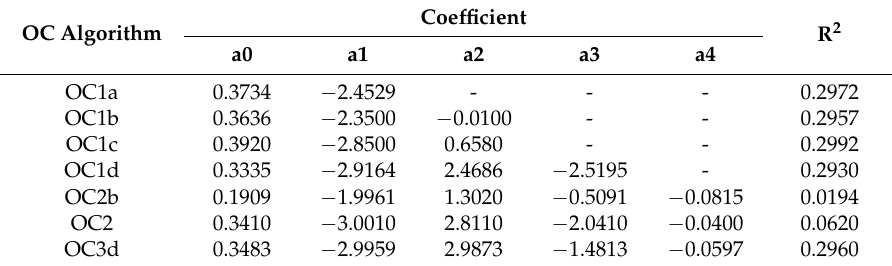
Table 3. Ocean Chlorophyll (OC) algorithms and performance of the Landsat-8 images.